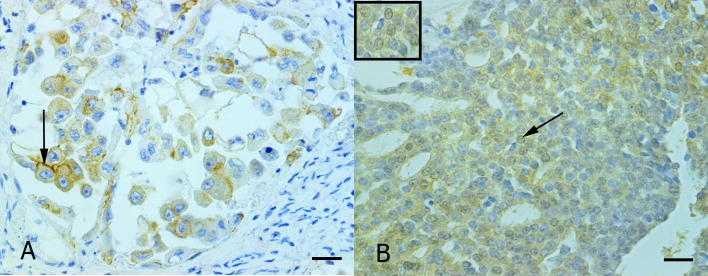
Photomicrographs illustrating E-cadherin and ZEB2 immunostaining of micropapillary carcinomas of the canine mammary gland.(A) Invasive micropapillary areas characterized by a decrease of E-cadherin expression. Some cells show high-intensity cytoplasmic membrane E-cadherin expression (arrow). This case was classified as 1+. Advance HRP peroxidase system and anti-E-cadherin; counterstained with Harris’s hematoxylin; scale bar, 30 μm. (B) The invasive micropapillary area is exhibiting neoplastic cells with the nuclear expression for ZEB2 (arrow). The inset shows details of the staining. Advance HRP peroxidase system and anti-ZEB2; counterstained with Harris’s hematoxylin; scale bar, 30 μm.